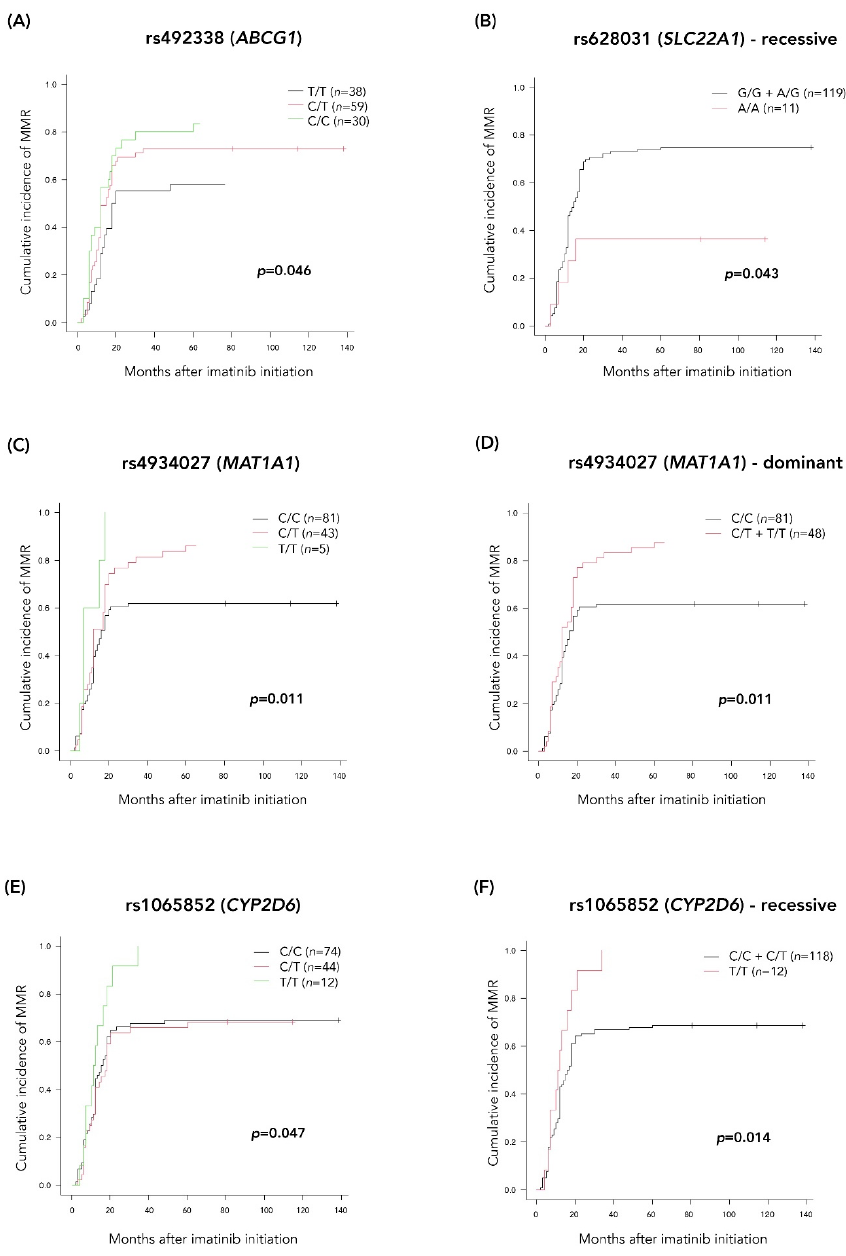
Figure 2. Cumulative incidence (95% CI) of MMR for the gSNVs with p ‐ value < 0.05. ( A ) 95% CI of MMR for rs492338 (ABCG1) for each of the three genotypes. ( B ) 95% CI of MMR for rs628031 (SLC22A1) grouped by recessive model. ( C , D ) 95% CI of MMR for rs4934027 (MAT1A) for each of the genotypes and grouped by dominant model. ( E , F ) 95% of MMR for rs1065852 (CYP2D6) for each of the genotypes and grouped by recessive model .